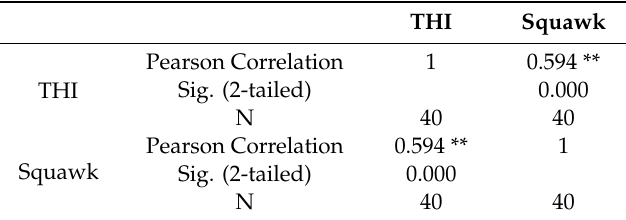
Table 6. Correlations between the squawk and